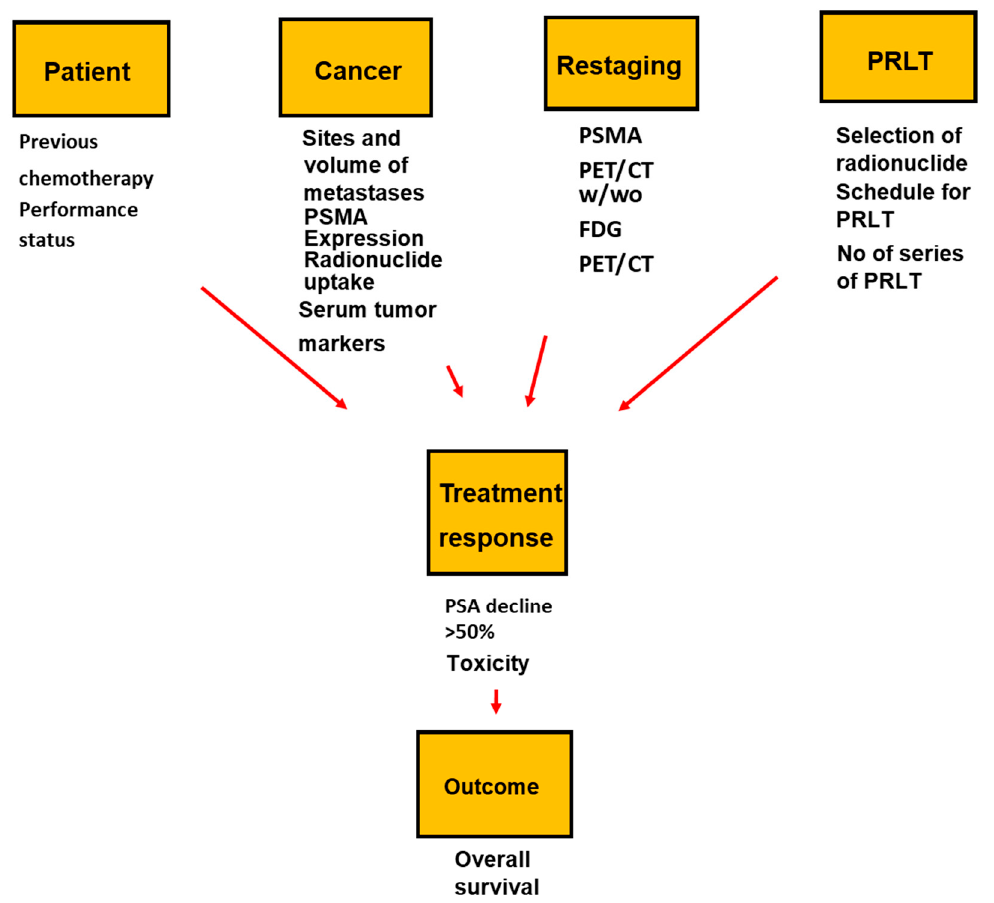
Figure 6. Conceptual model for factors impacting response and overall survival as patients with mCRPC are treated with PSMA based radioligand therapy (PRLT).